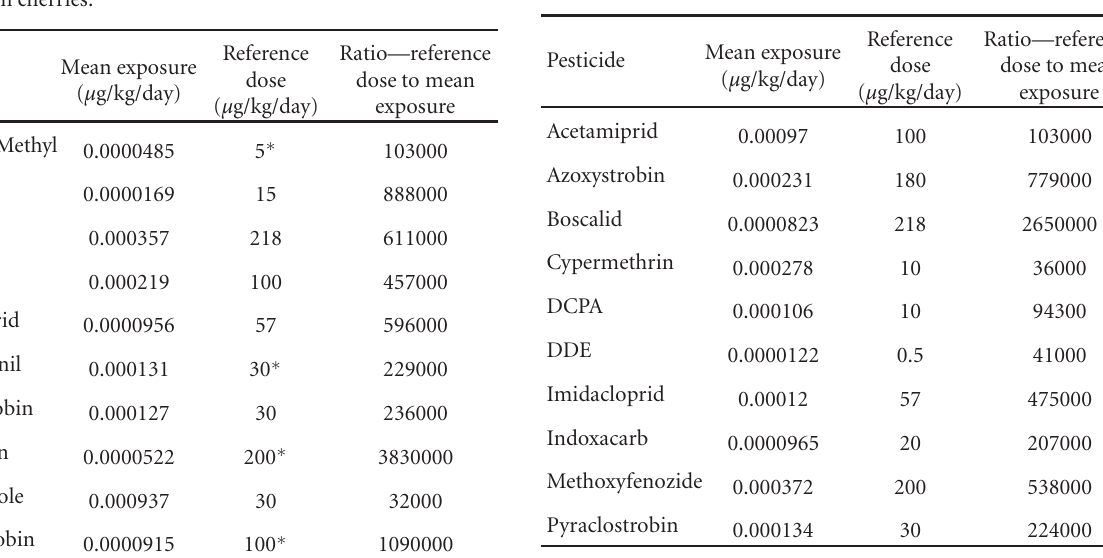
Table 8: Exposure estimates of the ten most frequently detected pesticides on